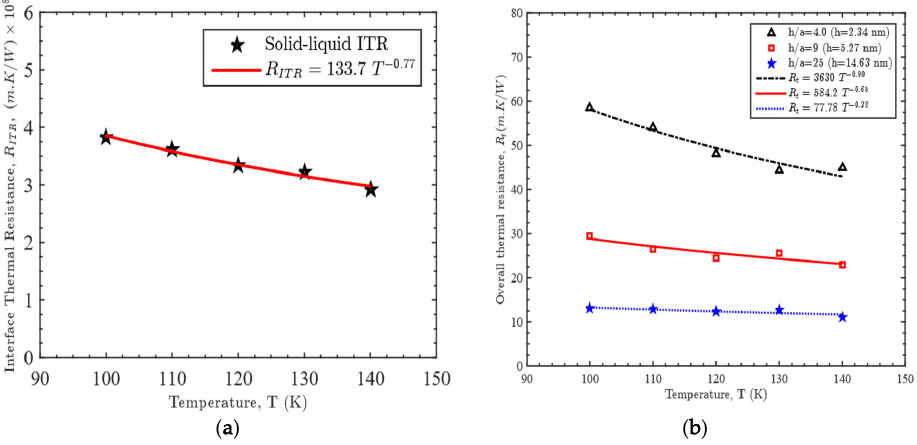
Figure 10. Temperature dependence of (a) interface thermal resistance, (b) overall thermal resistance.